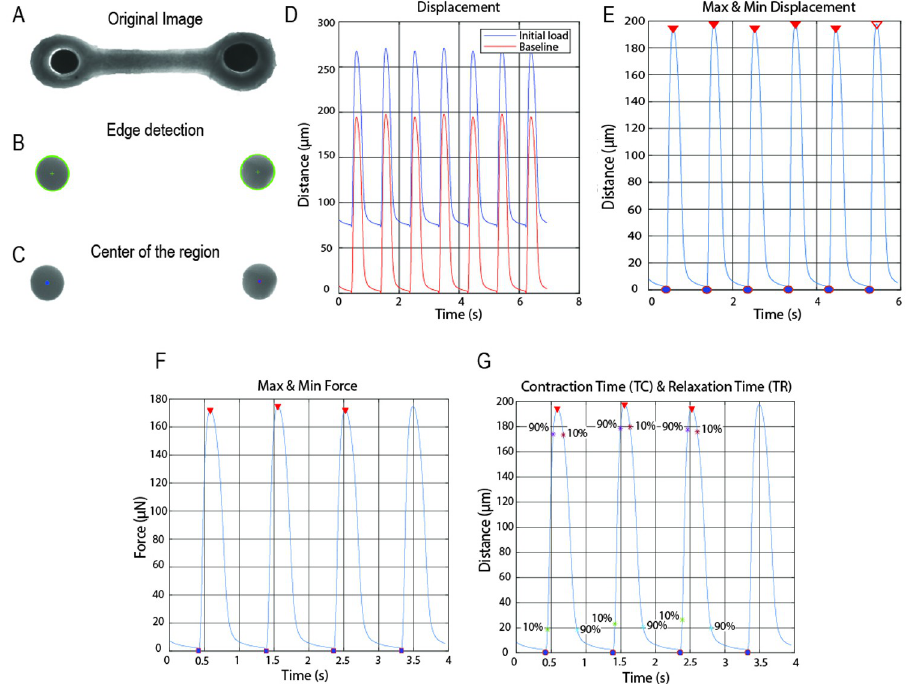
Fig 4. Contraction analysis by tracking black dots. (A) Original bright field image of an EHT around pillars with a black tip. (B) Edge detection of the black tip of the pillars from a bright field image. (C) Detection of the center of the pillars black region. (D) Displacement of the pillars over time with resting tension (Blue) and after removing the initial resting tension (Red). (E) Maximum and minimum detection of the contraction motion; complete contraction cycles are with filled marks. (F) Graph of the contraction force with the maximum and minimum. (G) Graph of displacement over time and also indication the moments to achieve 10% and 90% of contraction and relaxation.